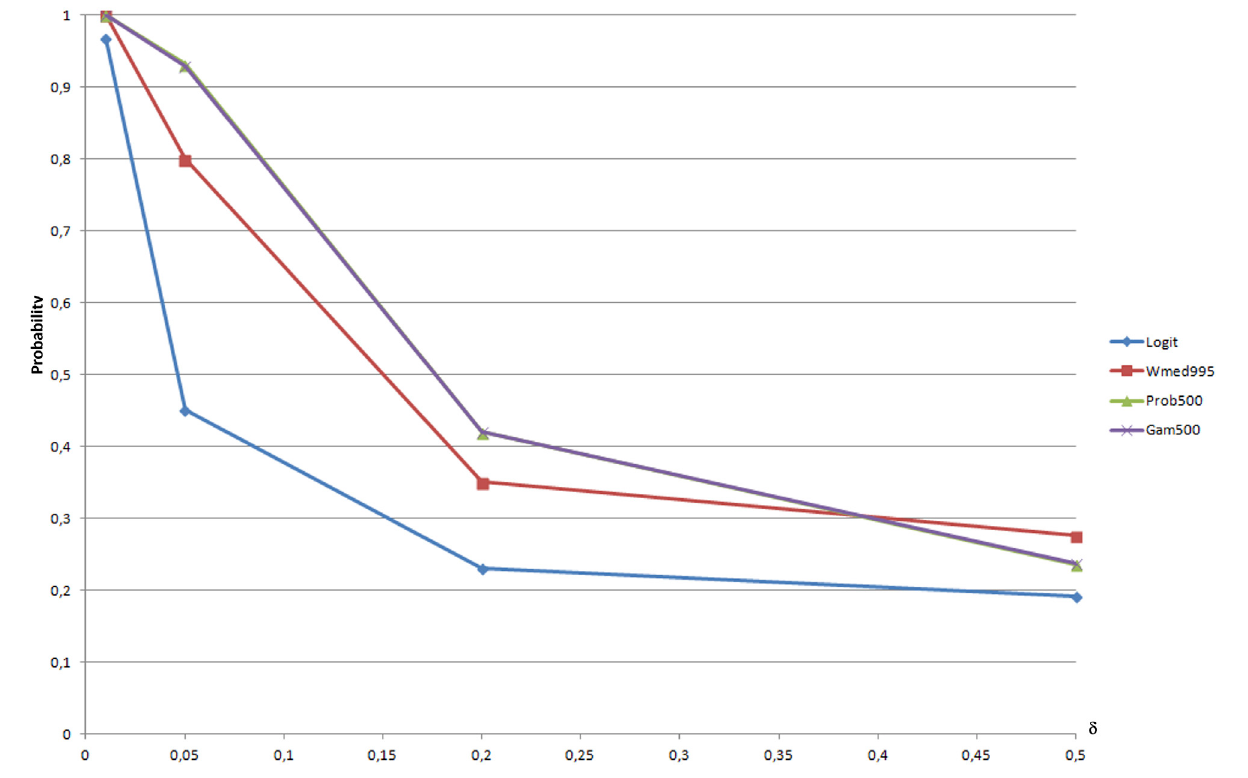
Frontiers in Future Transportation |